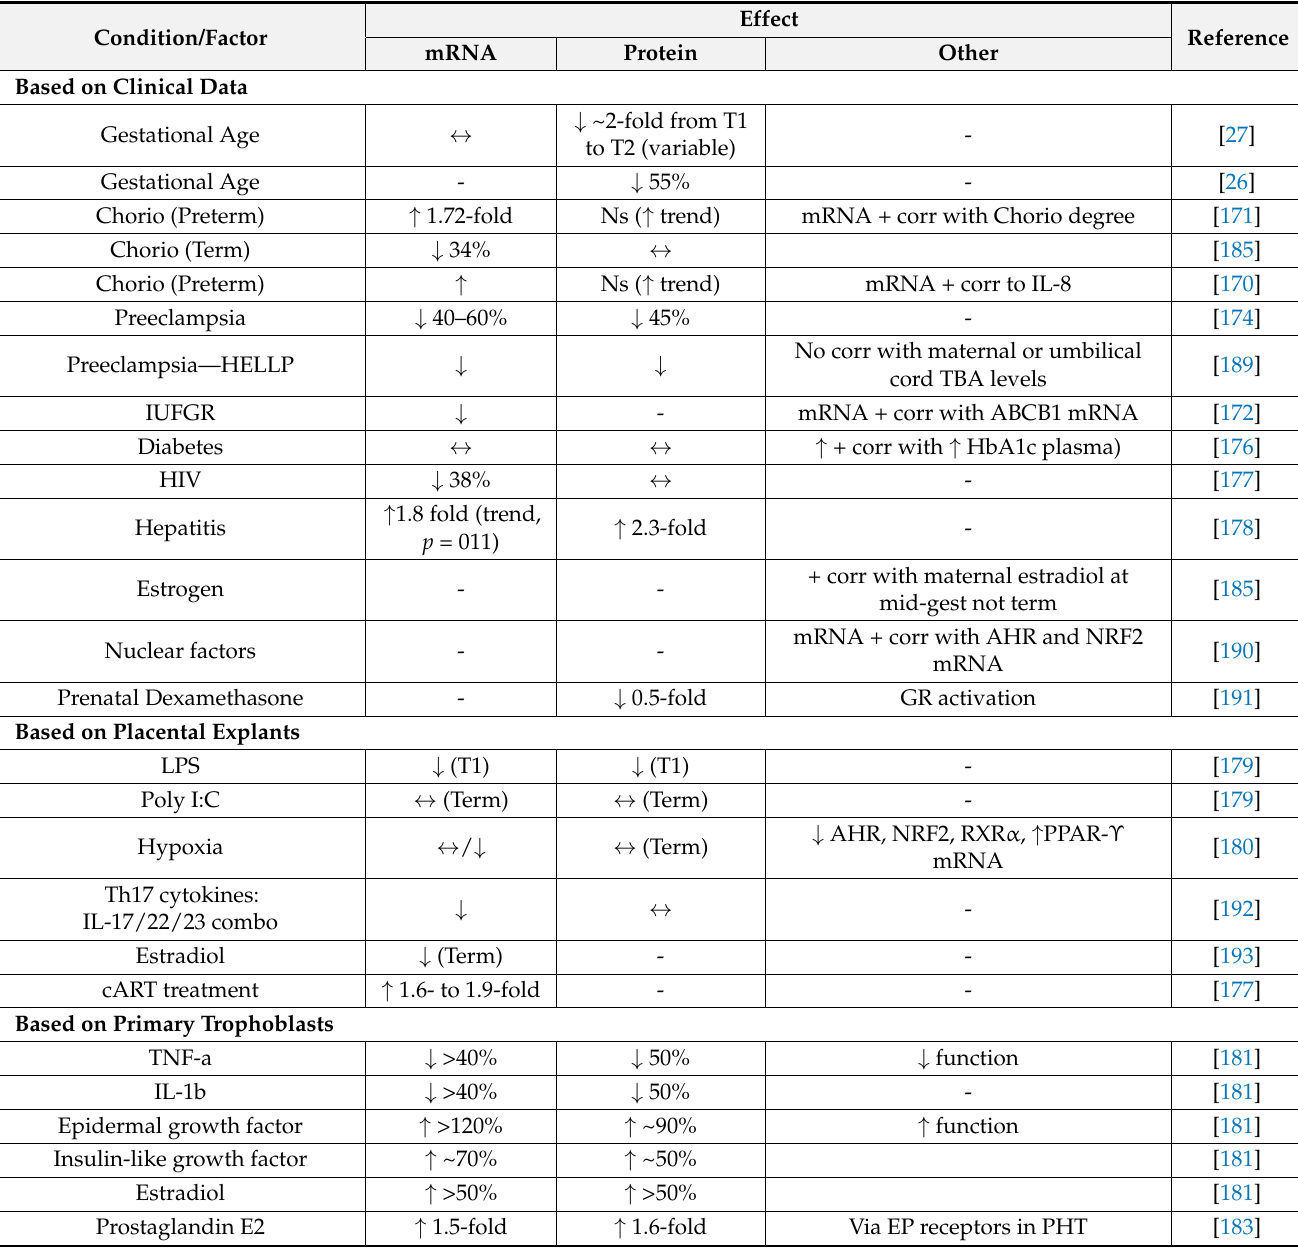
Table 2. Summary of ABCG2/BCRP alterations in the placenta in different physiological/ pathological